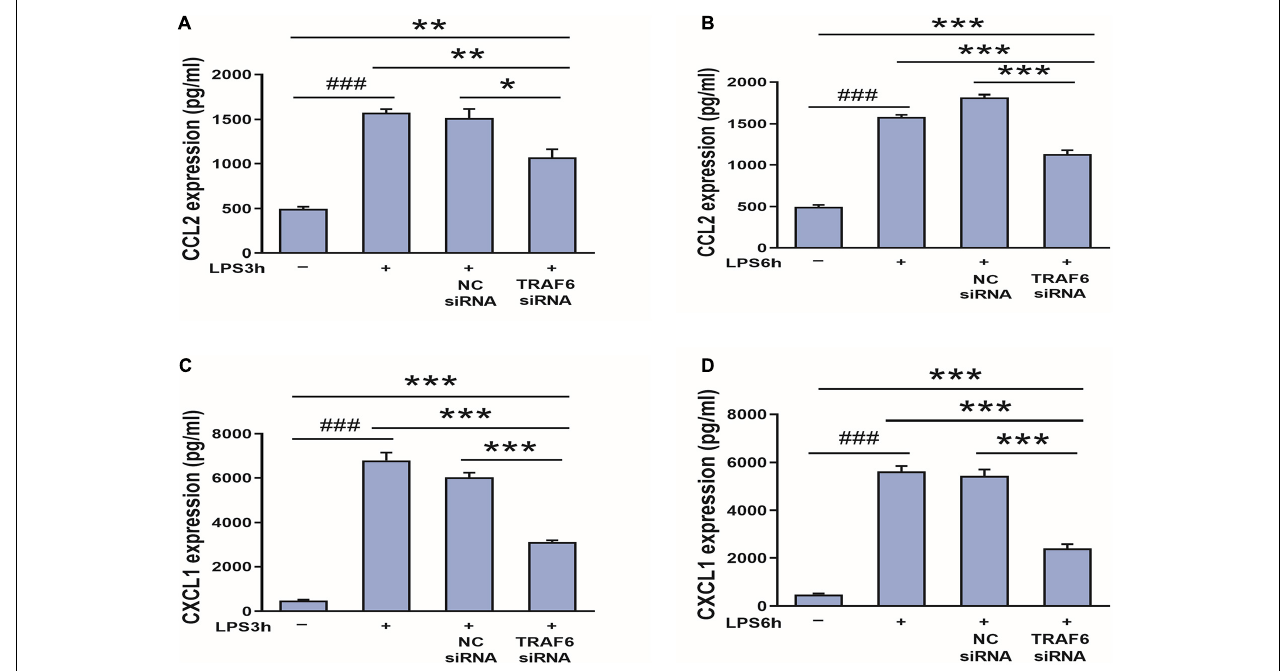
FIGURE 11 | TRAF6 knockdown downregulates CCL2 and CXCL1 expression in LPS-activated astrocytes. (A,B) TRAF6 siRNA downregulated CCL2 expression. * P < 0.05, ** P < 0.01, and *** P < 0.001 vs. TRAF6 siRNA group. ### P < 0.001 vs. control group. (C,D) TRAF6 siRNA downregulated CXCL1 expression. *** P < 0.001 vs. TRAF6 siRNA group. ### P < 0.001 vs. control